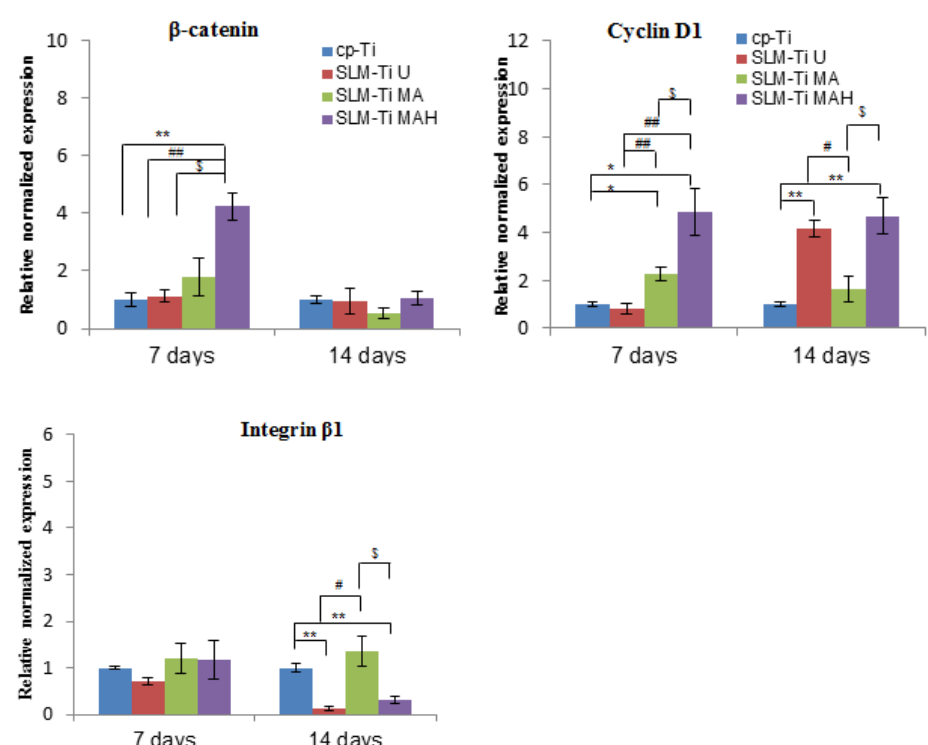
Figure 10. Real-time PCR for osteogenic gene expression of MC3T3-E1 cells cultured on cp-Ti and SLM-Ti with or without bioactive treatment at 7 and 14 days. The data were normalized to GADPH. All values are presented as the mean ± sd (n = 3), * different from cp-Ti at * p < 0.05, ** p < 0.01; # different from SLM-Ti U at # p < 0.05, ## p < 0.01, $ different from SLM-Ti MA at $ p < 0.05, $$ p < 0.01.